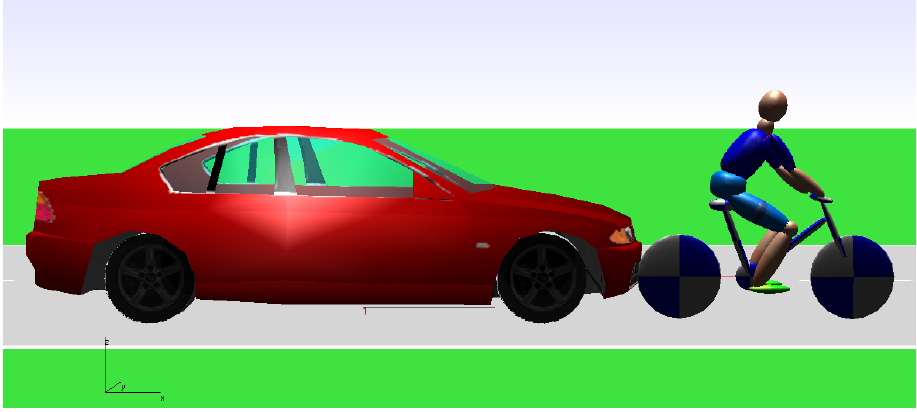
Figure 2. Bicycle and cyclist model.